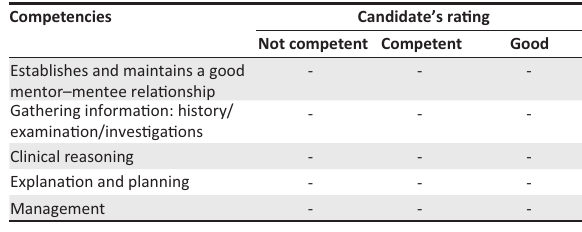
FIGURE 2: Marking template for consultation